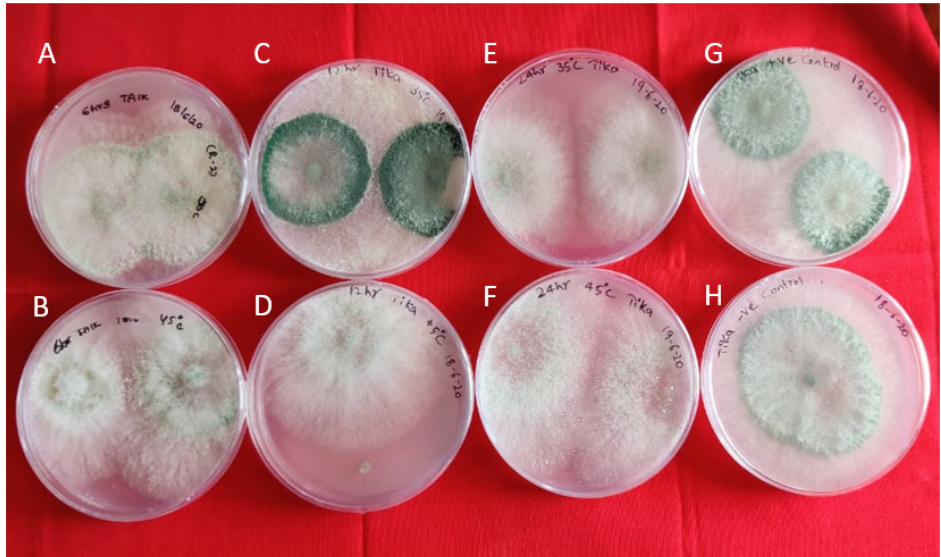
Figure 2. Interaction of Bg_9562 protein and TAIK1 mycelial discs at varied temperatures and incu- bation periods: ( A , B ) 6 h incubation at 45 °C, 35 °C; ( C , D ) 12 h incubation at 45 °C, 35 °C; ( E , F ) 24 h incubation at 45 °C, 35 °C; ( G ) untreated protein (positive control); ( H ) TAIK1 (negative control); no effect of protein on mycelial growth. Observations taken after 24 h.